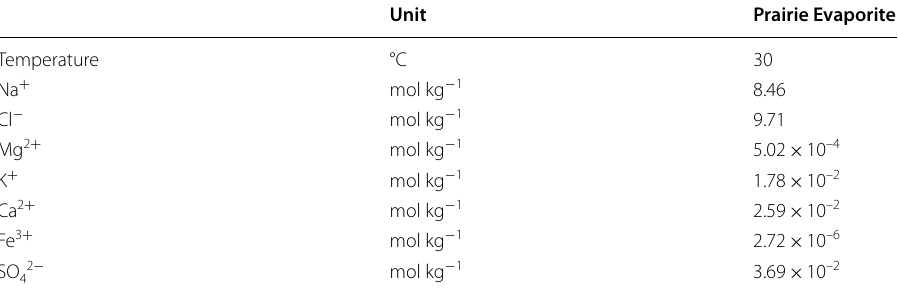
Table 1 Concentrations of ions in a saturated NaCl-brine based on the fractions for the Prairie Evaporite